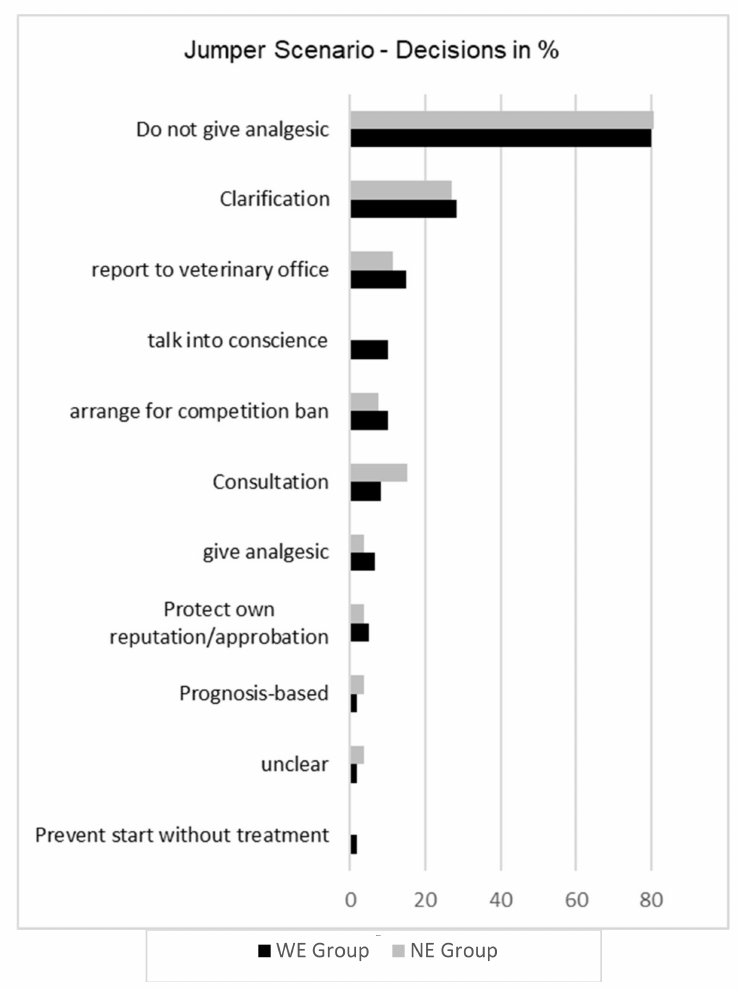
Figure 2. Decisions for all three scenarios, both groups. Answers in